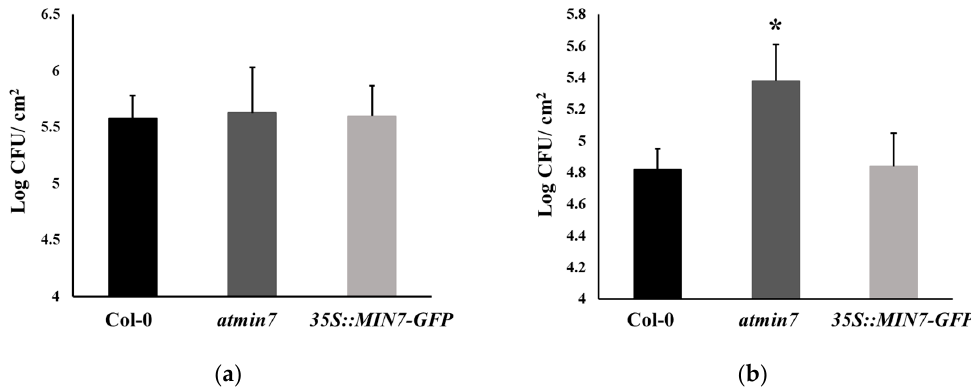
Figure 5. The atmin7 mutant plants are more susceptible to the Pto DC3000 infection on the leaf surface by the spray treatment but not the syringe infiltration. ( a ). Bacterial multiplication in the leaves of WT, atmin7 , and 35S::MIN7-GFP plants following the syringe infiltration with 1×10 5 CFU/mL of Pto DC3000. ( b ). Bacterial multiplication in the leaves of WT, atmin7 , and 35S::MIN7-GFP plants following